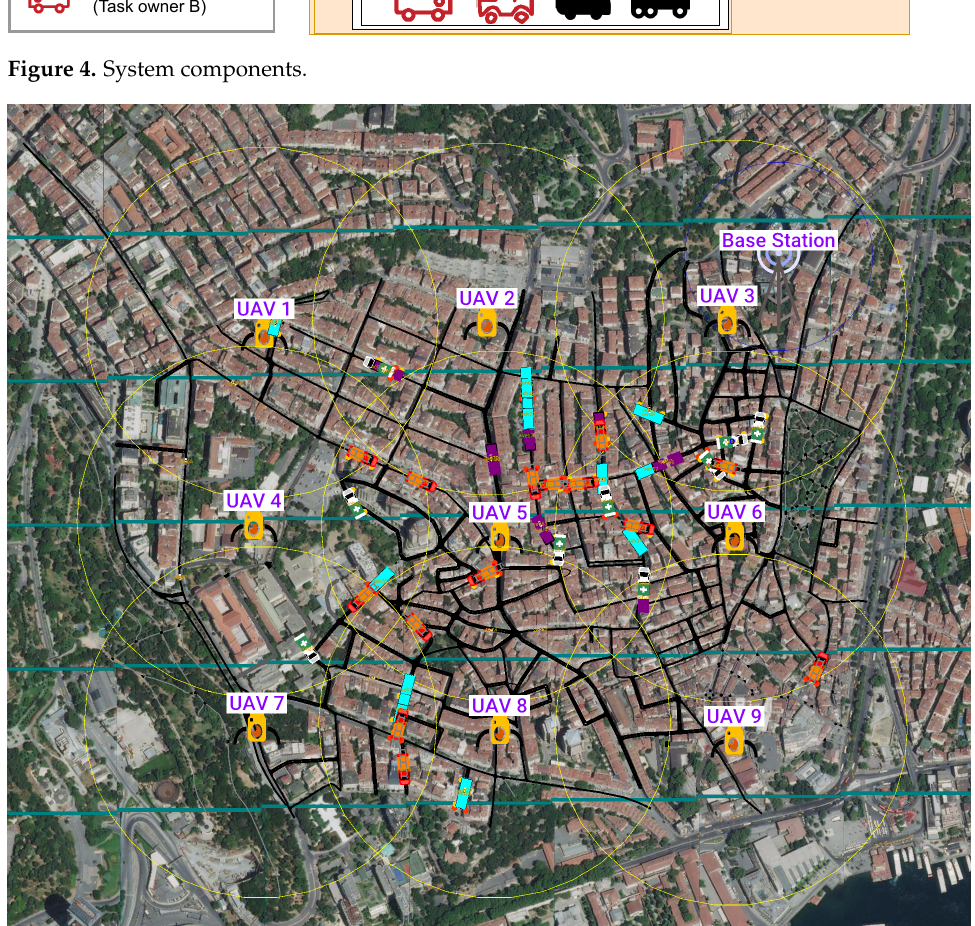
Figure 5. The visualization of topology elements in Besiktas network. The terrestrial coverage ranges of UAVs are indicated by the yellow circles around